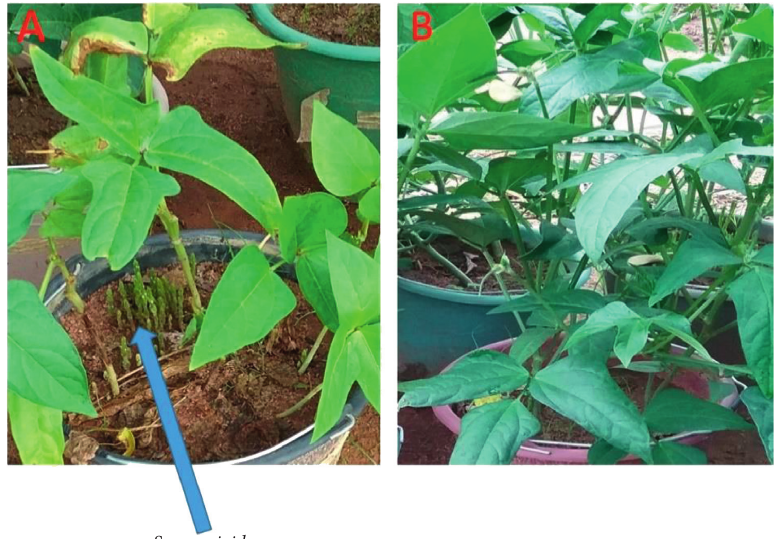
Figure 1: Response of cowpea plants to S. gesnerioides infestation at 5 weeks after sowing seeds in Striga -infested soil. (a) Striga -susceptible cowpea plants under stress by Striga seedlings parasitism. (b) Striga -resistant cowpea plants showing vigorous vegetative growth without Striga emergence. Table 3: Striga count per pot and days to emergence of Striga . Genotypes